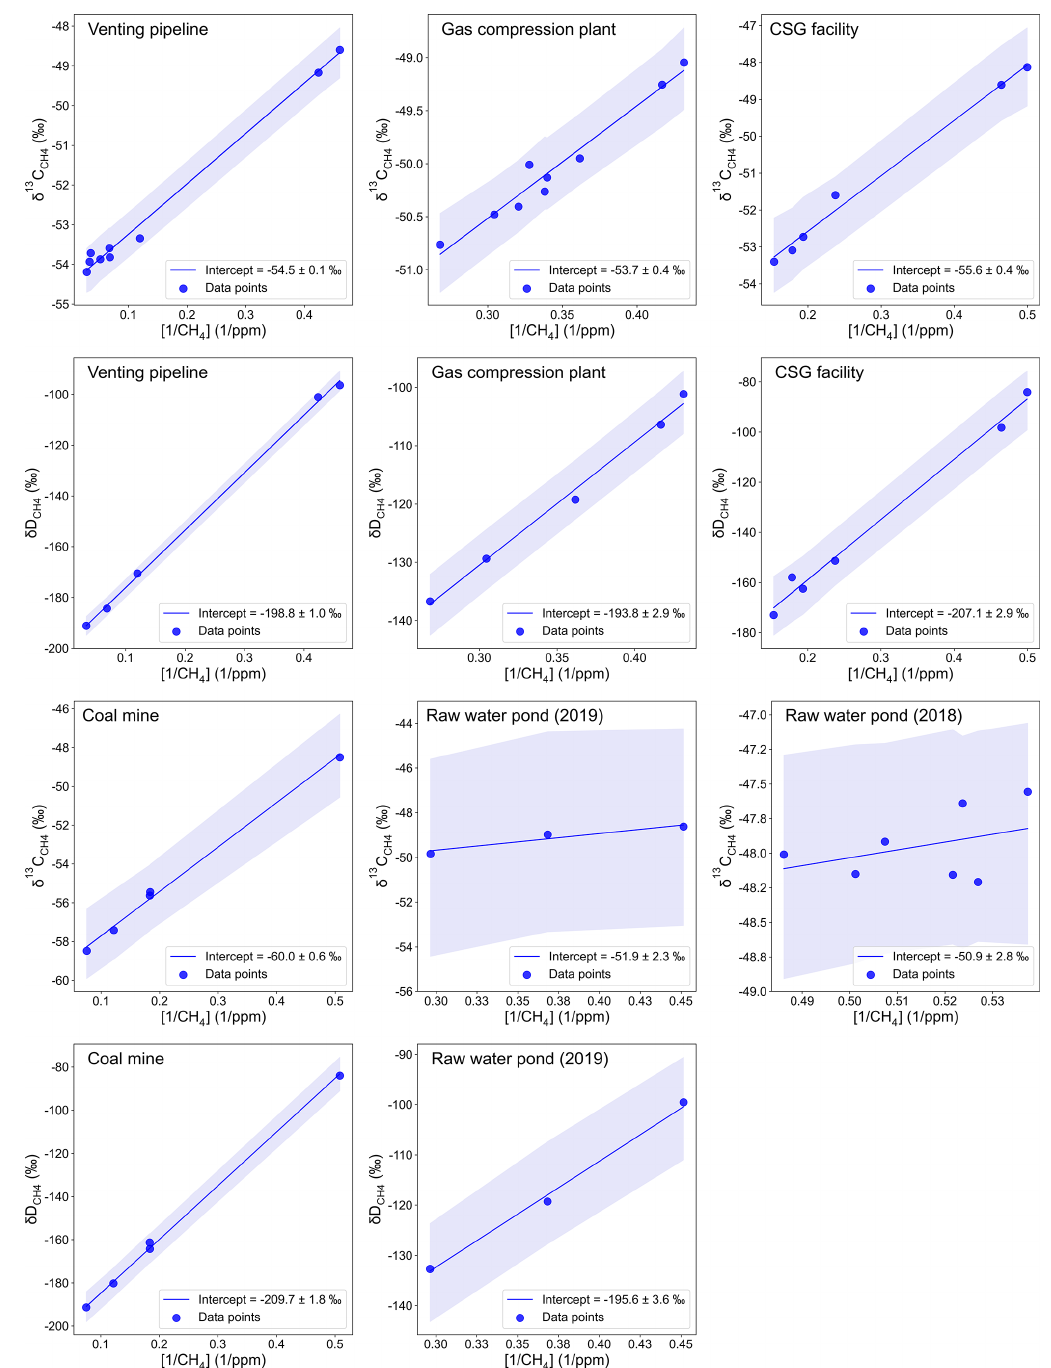
Figure A3. Keeling plots of all data from CSG infrastructures and a coal mine analysed using Bayesian linear regression. Upper panels show the results for δ 13 C and lower panels show the results for δ